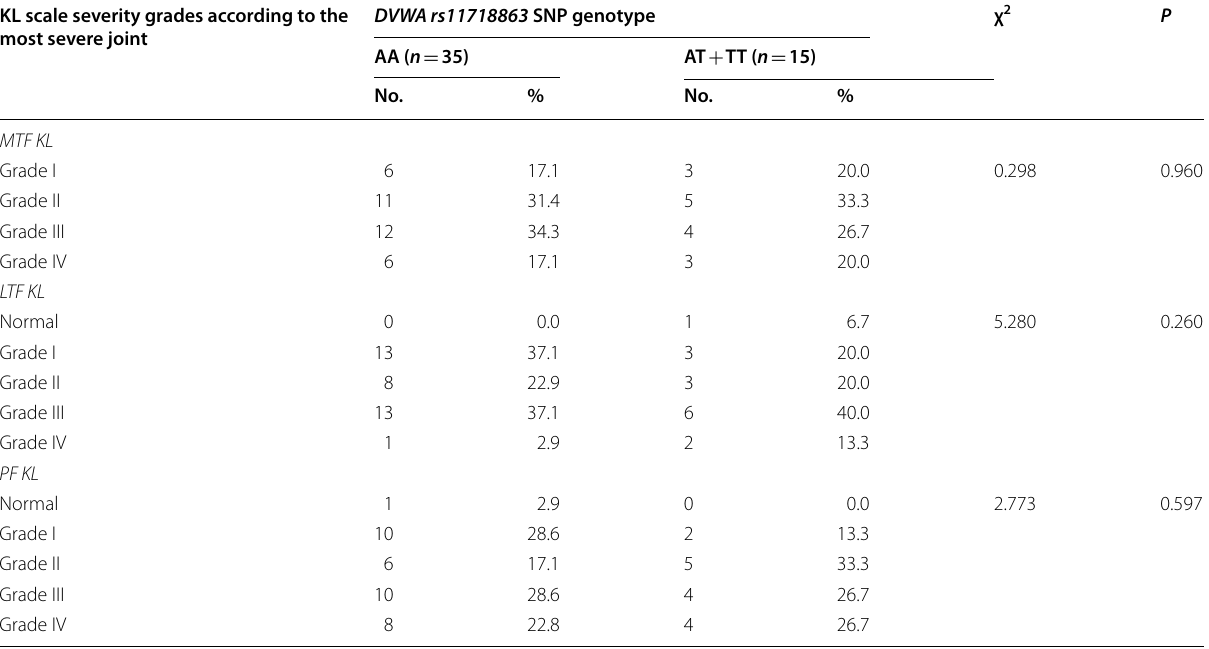
Table 6 Relation between DVWA rs11718863 single nucleotide polymorphism with KL scale severity grades of the knee joint in